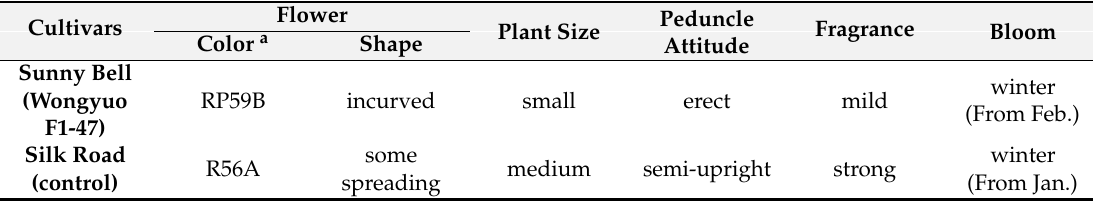
Table 1. Morphological characteristics of a new hybrid, Cymbidium “Sunny Bell”. Flower Cultivars